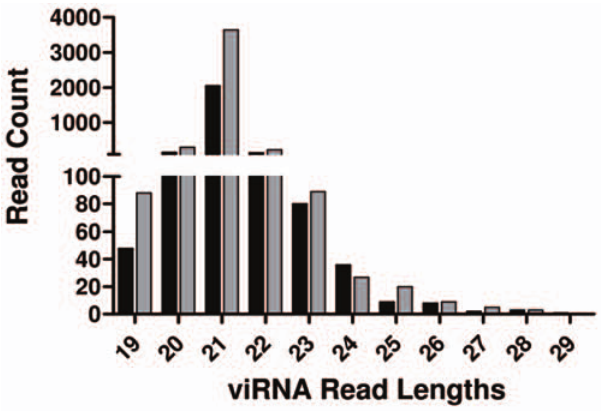
Figure 1. Size and Abundance of Small RNA Reads Mapping to the WNV Genome. The total abundance of sRNAs mapping to the WNV genome based on sRNA length. Black and grey bars correspond to 7 and 14 days post infection, respectively.